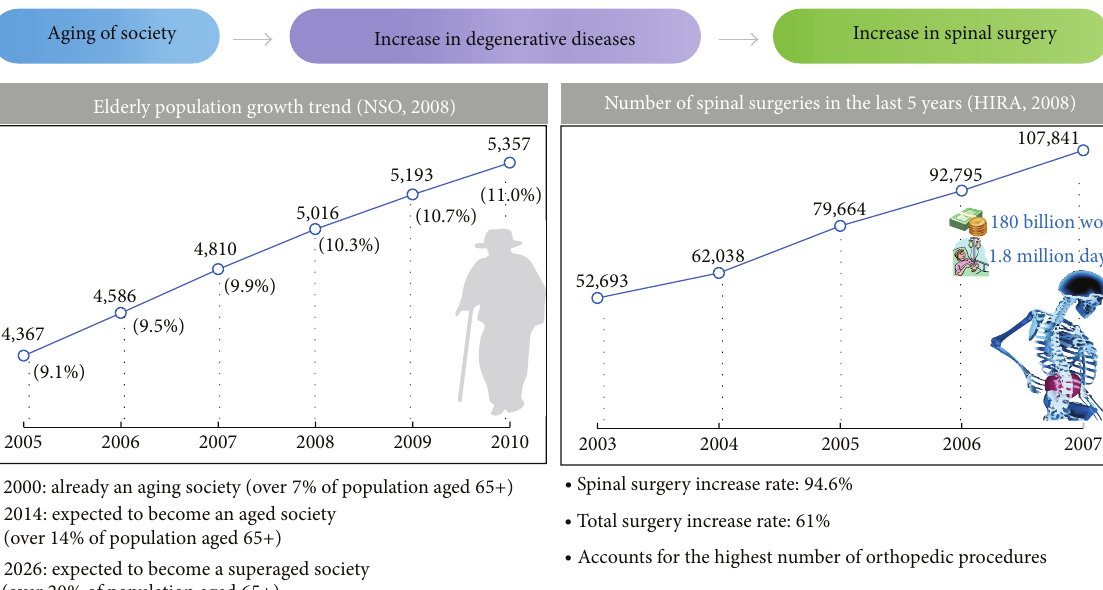
Figure 1: Status of an aged society and spinal surgeries in